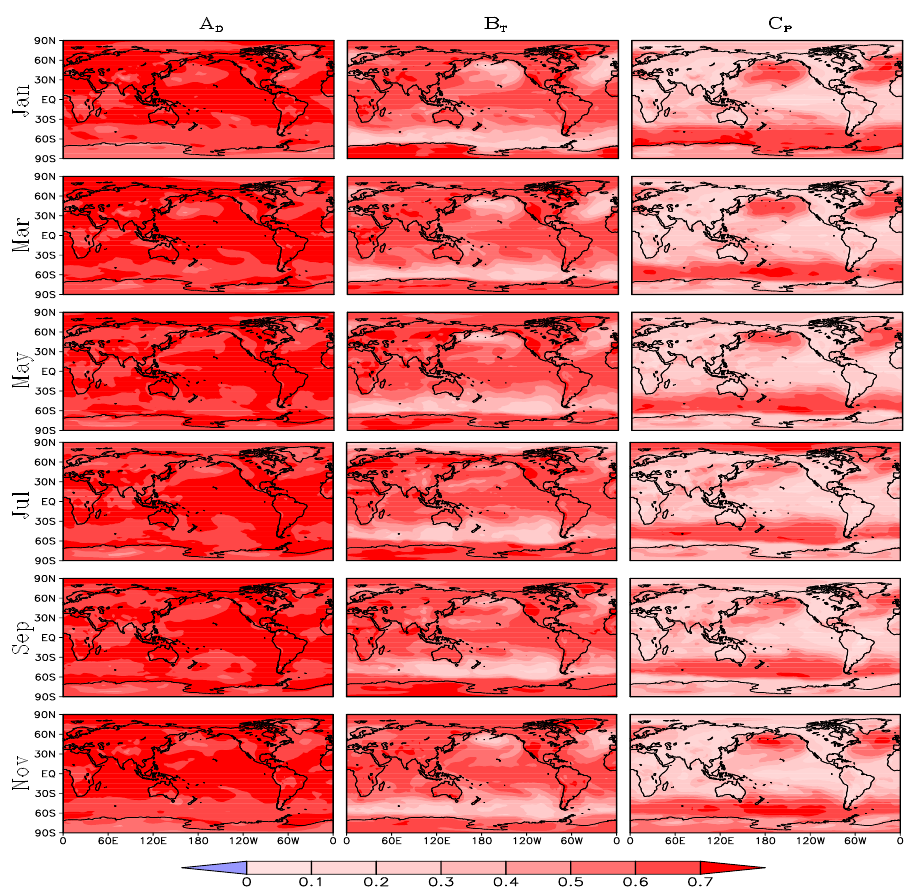
Figure 2. Distributions of the coefficients A D ( left ), B T ( middle ), and C P ( right ) obtained from the plane fitting, for the six selected months. plane fitting, for the six selected